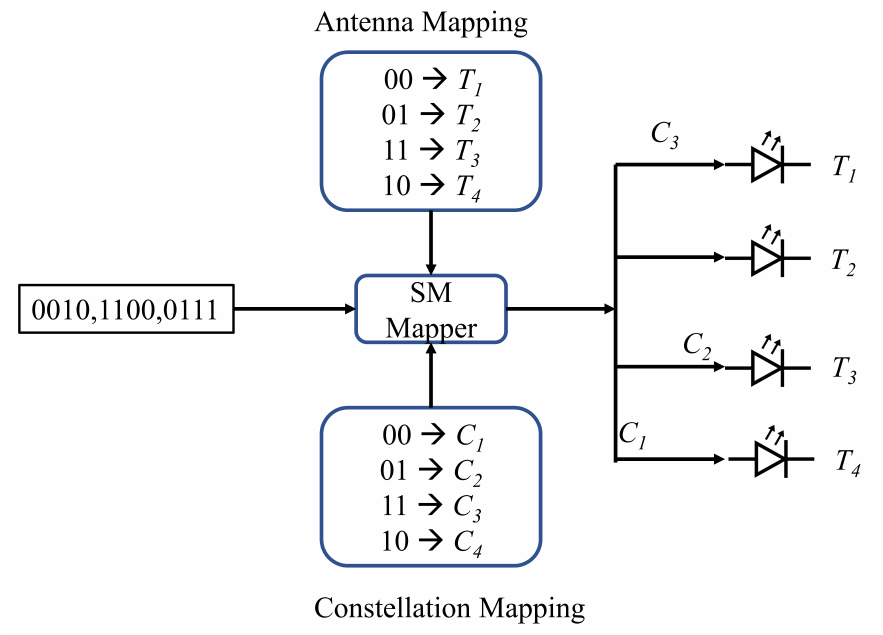
Figure 6. SM example for MIMO communication for each of the